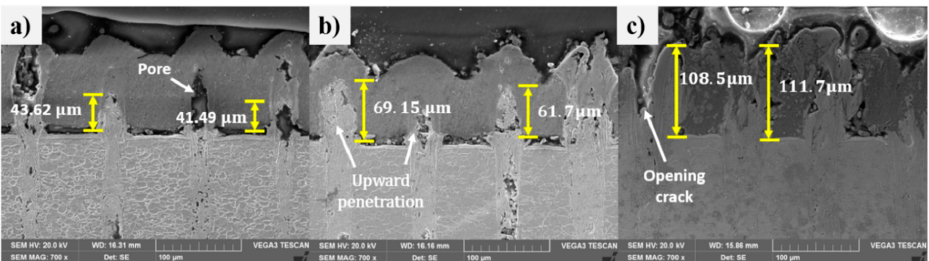
Figure 6. Centerline cavities, root cavities and root dropout.